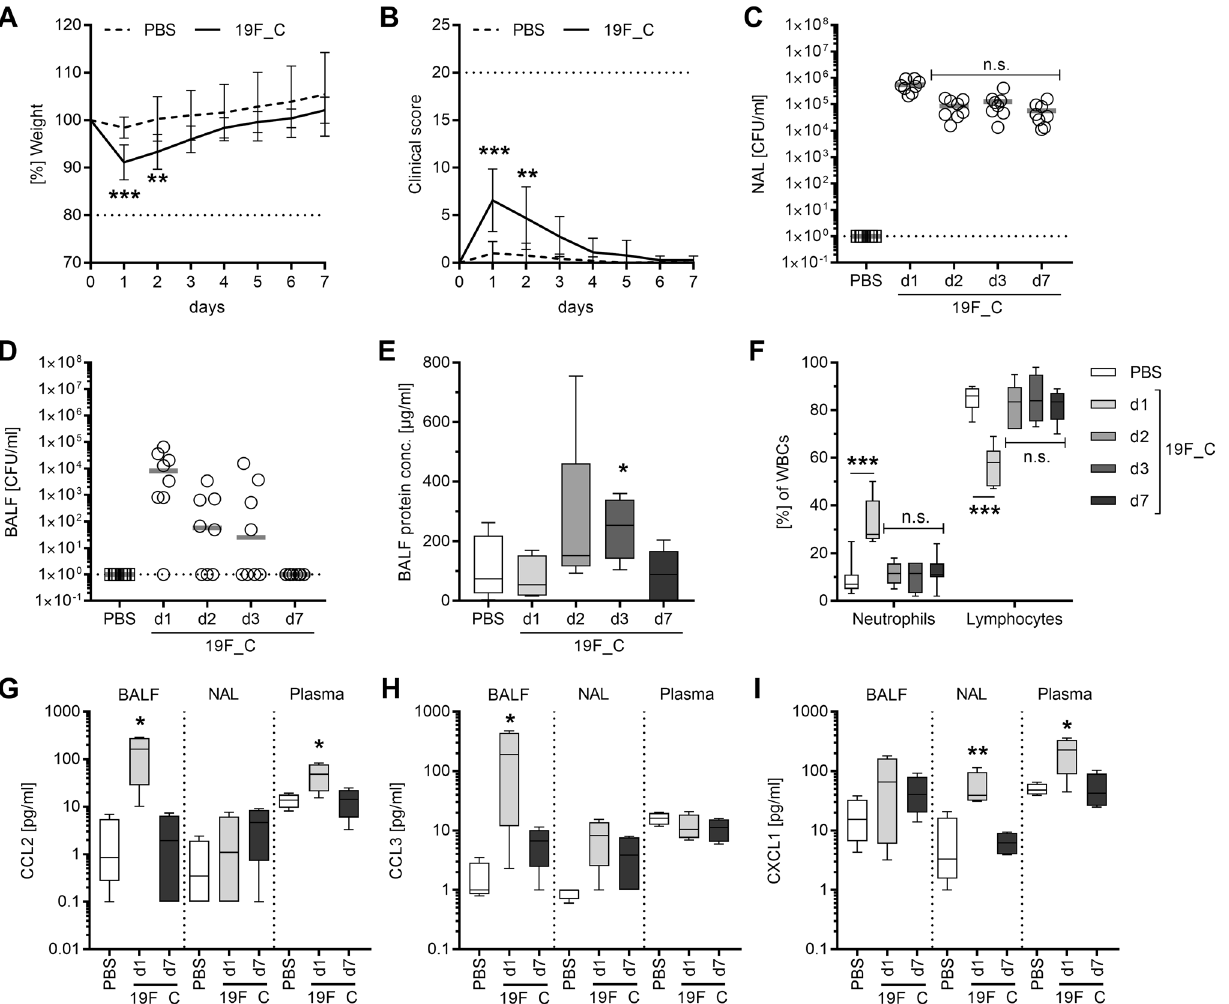
Figure 1. C57BL/6J mice are susceptible to S. pneumoniae 19F colonization. Female C57BL/6J mice were intranasally colonized with 1 × 10 7 CFU of S. pneumoniae 19F (19F_C) or challenged with PBS and monitored over seven consecutive days. ( A ) Weight and ( B ) clinical score were monitored daily. Horizontal dotted lines in A and B indicate termination conditions (20% weight loss and/or clinical score of 20) of the experiment. CFU counts in ( C ) nasal washes (NAL) and ( D ) bronchoalveolar fluid (BALF), ( E ) protein concentration in the BALF, ( F ) the white blood cell differential (WBC) limited to neutrophil and lymphocyte counts as well as ( G – I ) chemokine release were determined at indicated time points. Horizontal dotted lines in ( C ) and ( D ) indicate the limit of detection. Two independent experiments with four mice per group (total: n = 8) were performed. In general, mean values ± SD are displayed ( A , B ). Each dot represents one mouse and horizontal lines display mean values ( C – E ). The data in ( F – I ) are displayed as box plots. The level of significance between the PBS and all other groups was determined using Kruskal Wallis test with Dunn’s multiple comparison post-test (n.s., not significant, * p < 0.05; ** p < 0.01; *** p < 0.001). Dotted lines in A and B